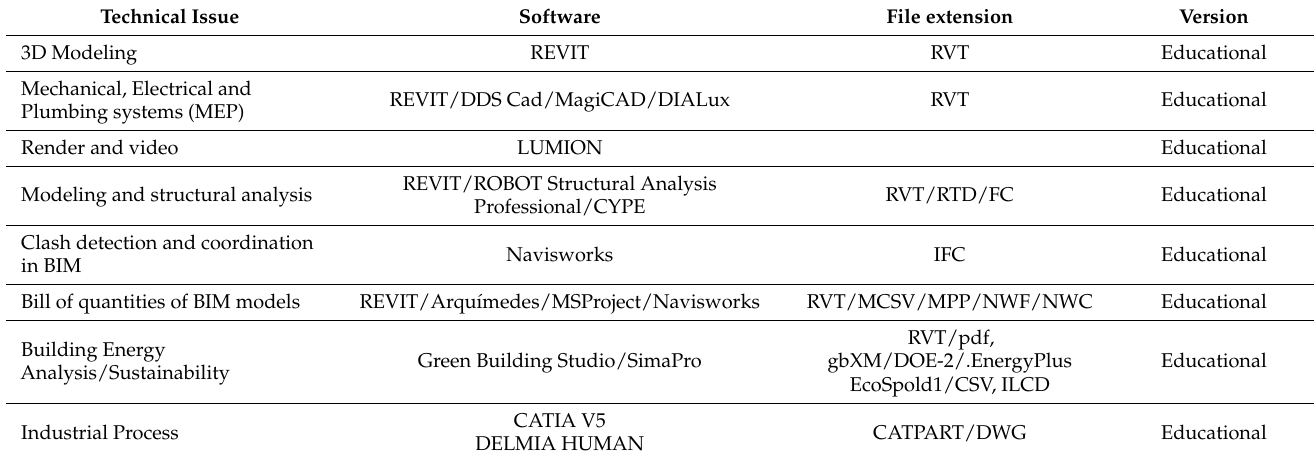
Table 8. Models generated according to technical issue and software used.